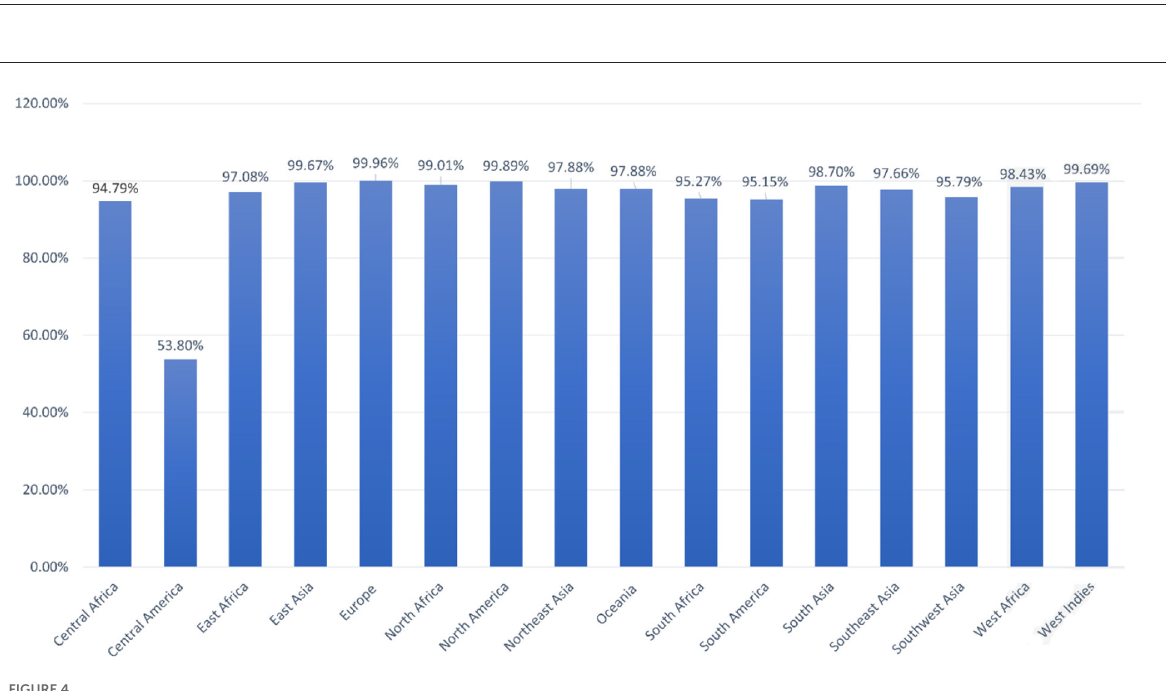
FIGURE4 World population coverage of the designed vaccine